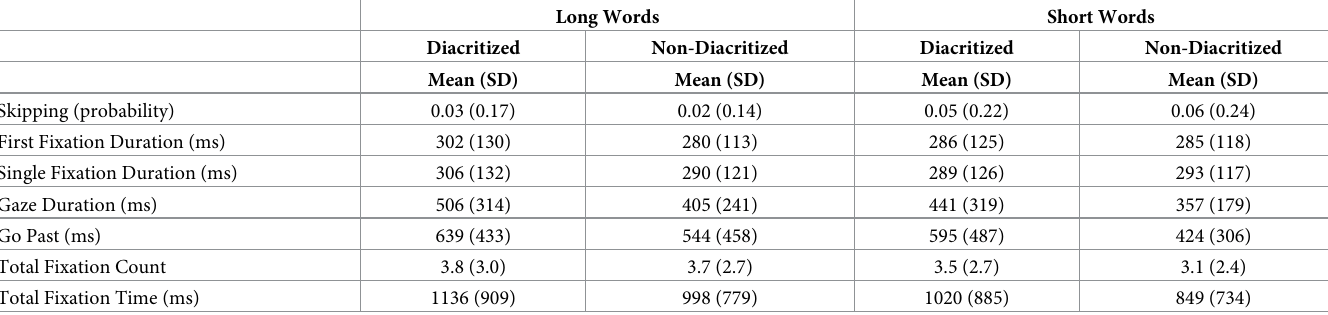
Table 3. Descriptive statistics of eye movement measures (experiment 2 –word length ×